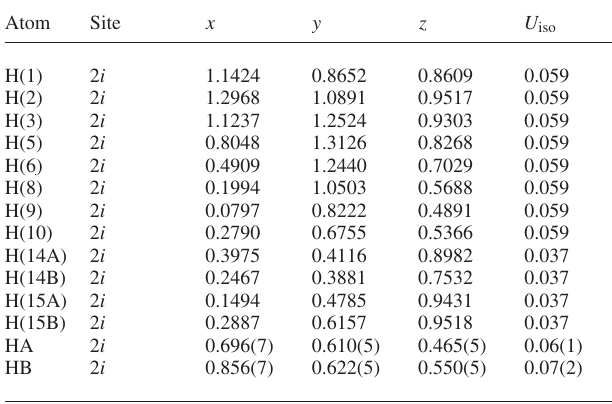
Table 2. Atomic coordinates and displacement parameters (in Å 2 )